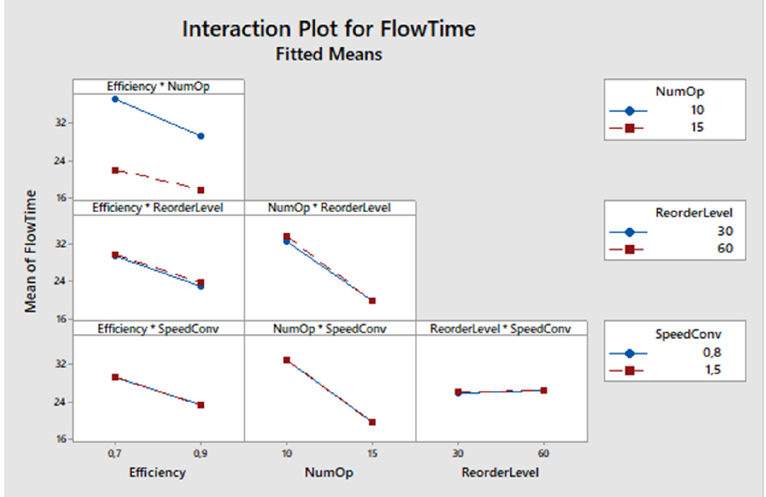
Figure 18. Interaction Plot for Flow Time.